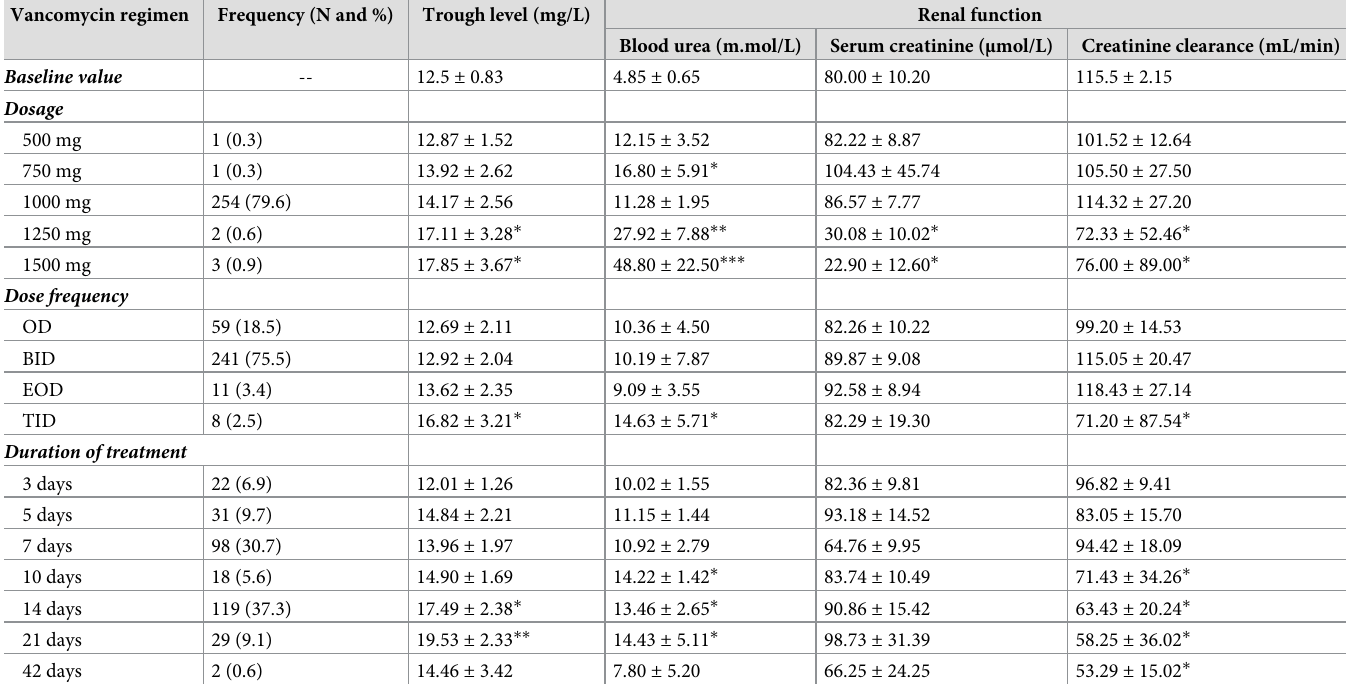
Table 3. Effect of vancomycin on the renal functions according to dose, frequency and duration of treatment. Vancomycin regimen